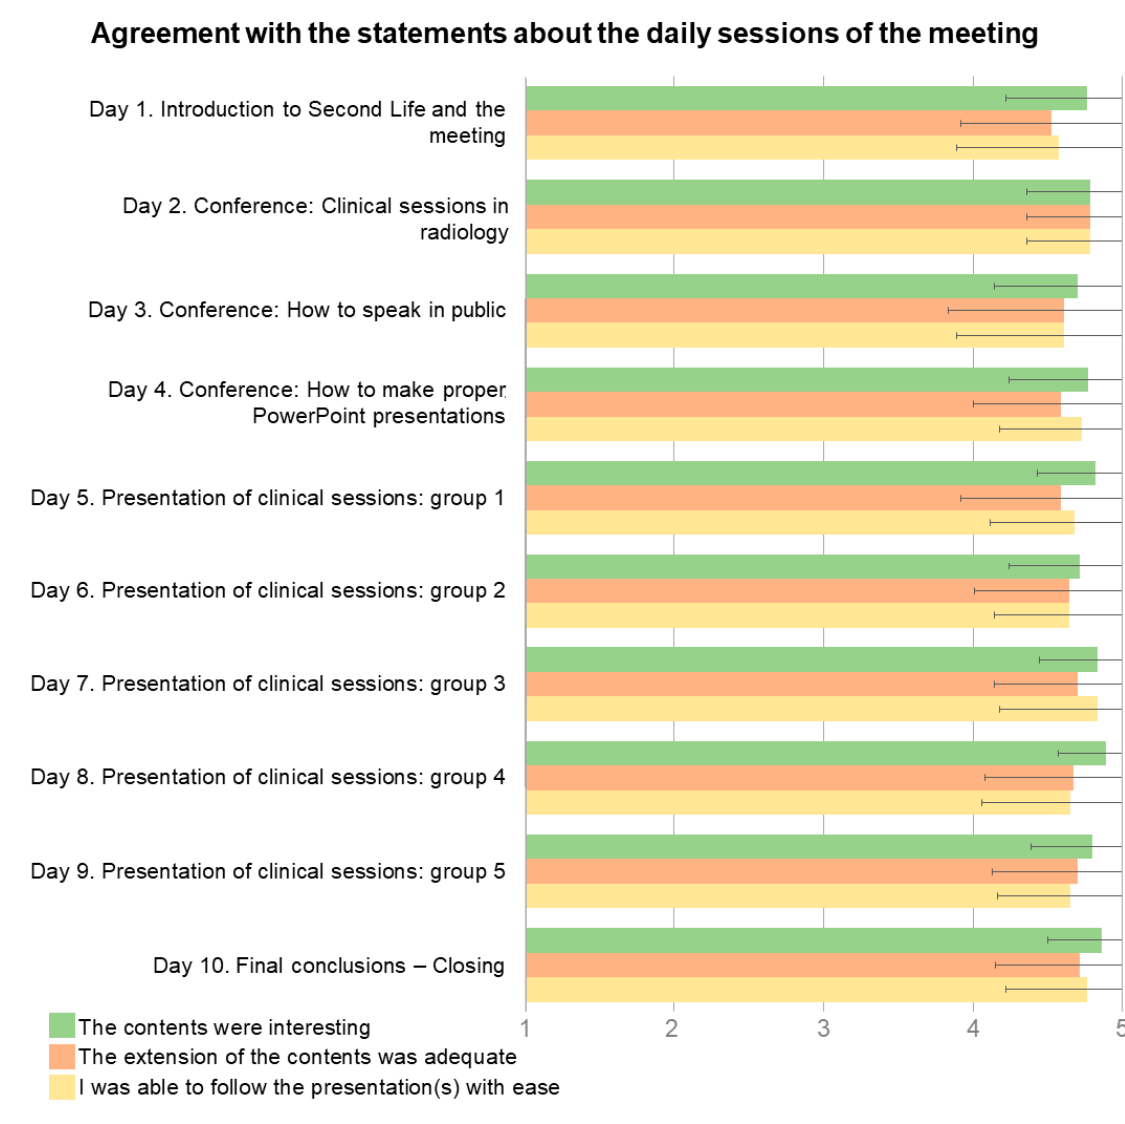
Figure 4. Bar chart with the responses of the participants on a Likert scale from 1 (totally disagree) to 5 (totally agree) related to the daily sessions of the meeting. Data are mean values; error bars represent the standard deviation. The mean rating from 1 to 10 points was higher or equal to 8.9 (Figure 5), which means a very positive perception of the overall experience, the organization of the project, the 3D environment, the contents, the interaction with colleagues and the work done by participants. The best rated of all the items included were the teachers (9.7 ± 0.6) and the usefulness of their training (9.4 ±